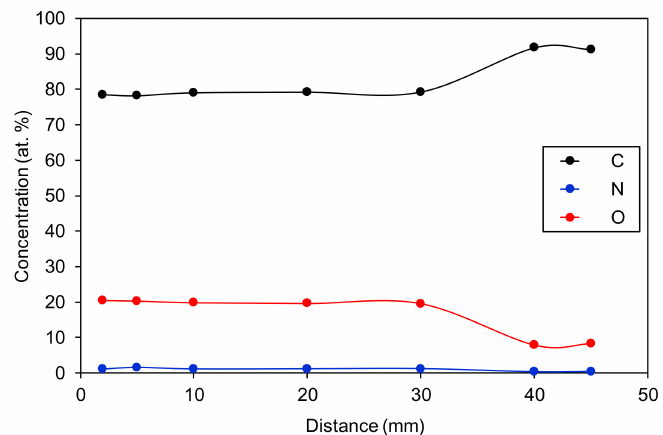
Figure 6. The surface composition of polystyrene measured in the center of the treated zone versus a distance of the APPJ nozzle from the sample surface. The treatment time was 30 s.